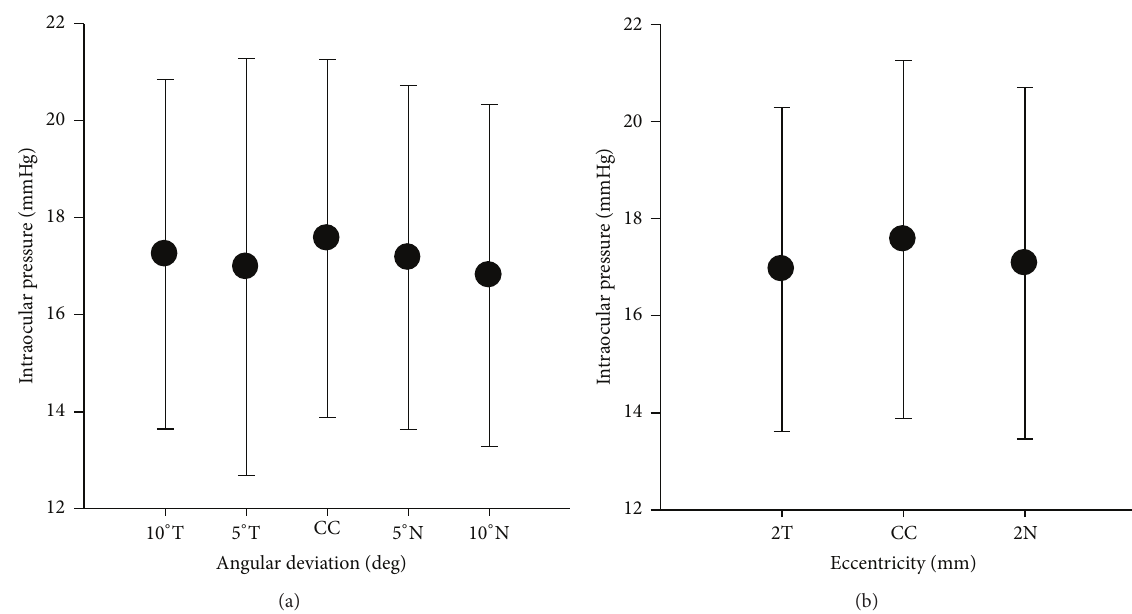
Figure 3: Mean iCare IOP measurements at CC versus specified lateral and angular deviations. Deviating the ICare tonometer probe from the optimal position had little effect on measurements, except at 10 ∘ N, where the underestimate of IOP reached levels of significance. Error bars represent ±